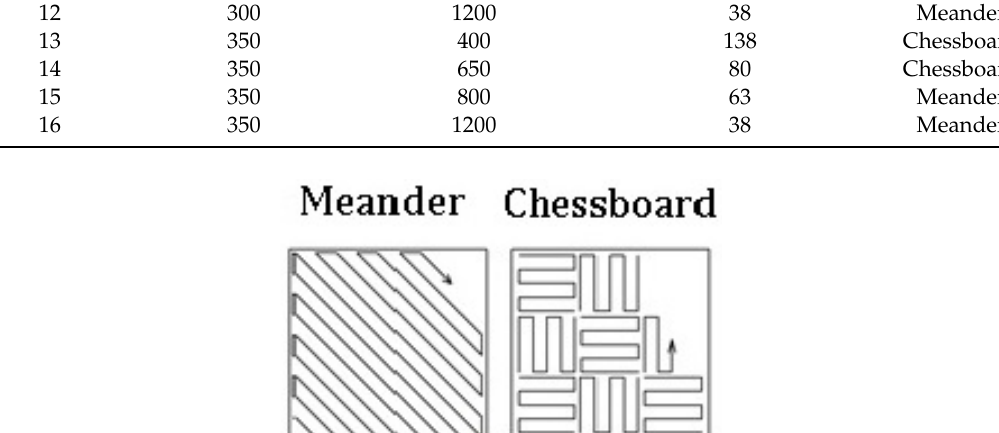
Table 1. Conditions used for selective laser melting. Figure 2. Used scanning strategies Figure 2. Used scanning strategies [21].